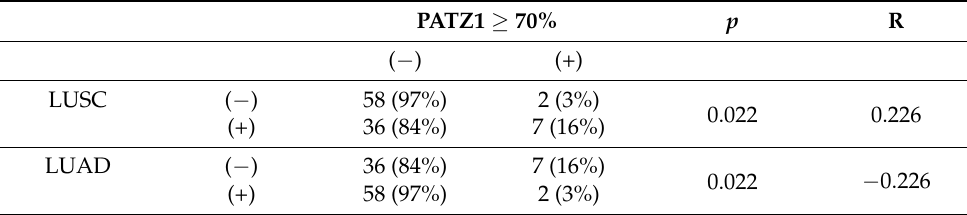
Table 5. Contingency table showing the correlation between High PATZ1 and NSCLC subtype 1 .